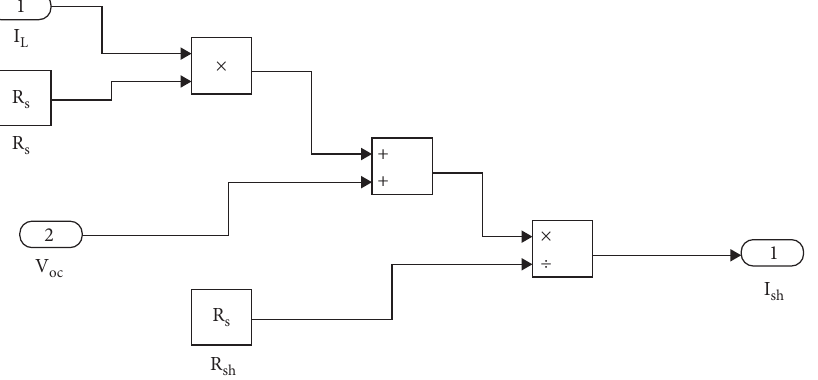
Figure 21: Modelled and implemented I